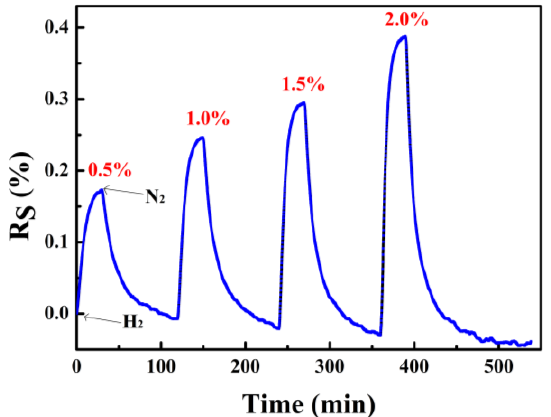
Figure 8. Response curve of the PdNi film hydrogen sensor under different H 2 concentrations.